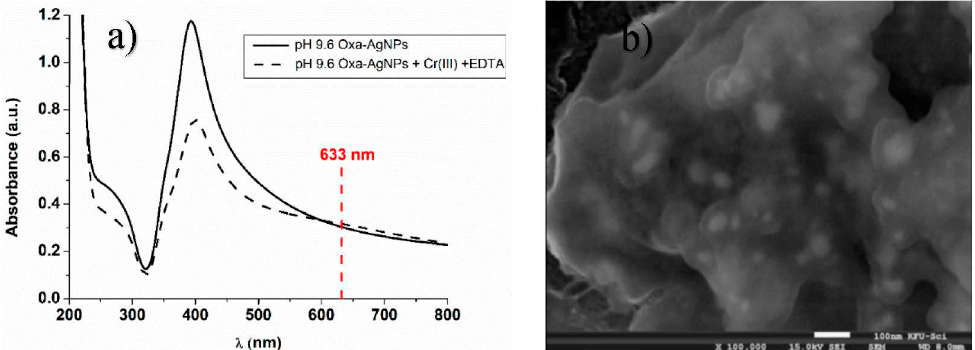
Figure 8. ( a ) UV-visible spectra of oxalate capped silver nanoparticles. Black solid line: silver nanoparticles at pH = 9.60 (Oxa-AgNPs); black dashed line: Oxa-AgNPs in the presence of the mixture Cr (III)-EDTA. ( b ) SEM images of Oxa-AgNPs mixed with EDTA + Cr (III) at different pH = 9.6.